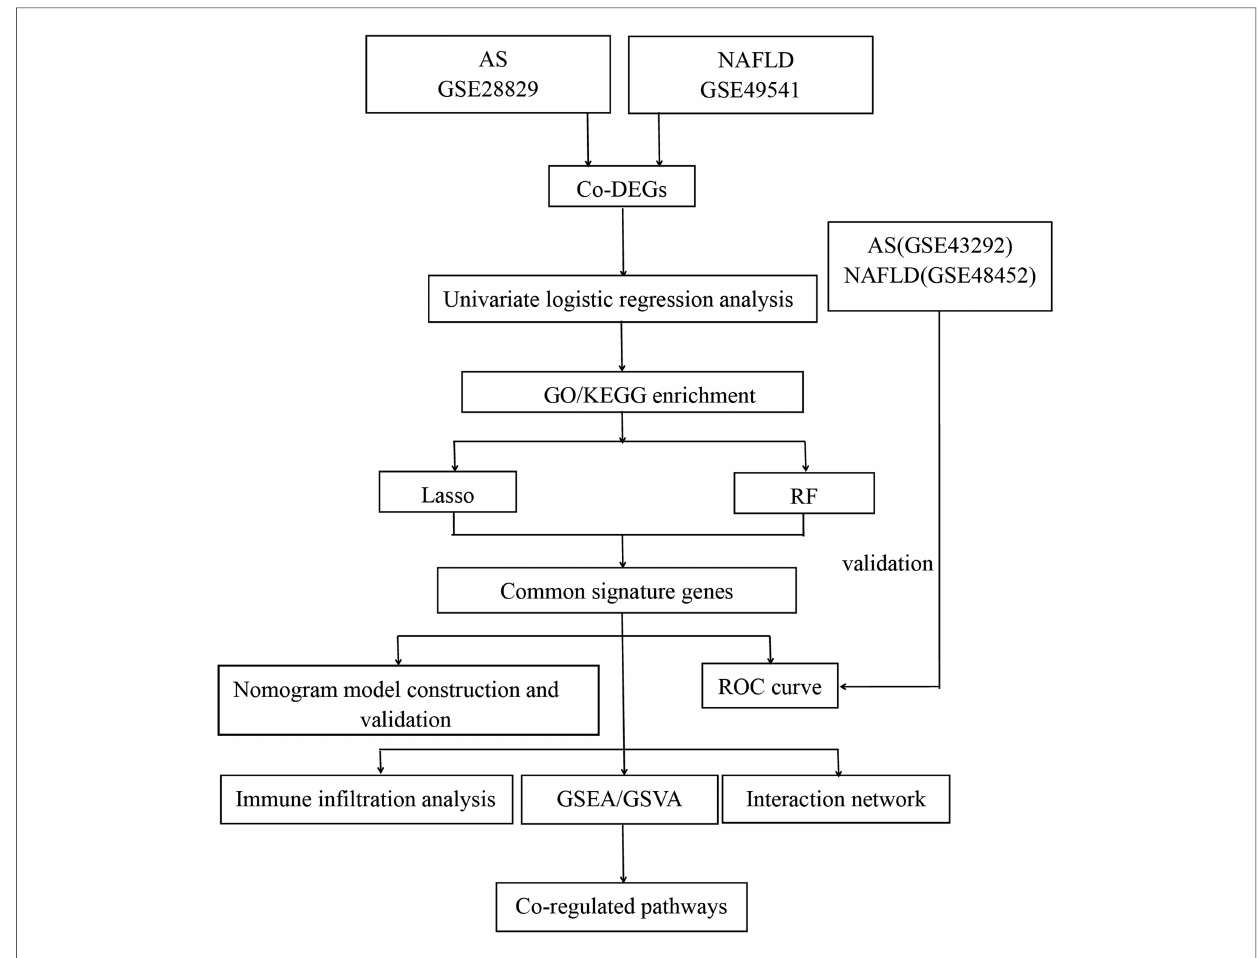
FIGURE 1 Flowchart of the